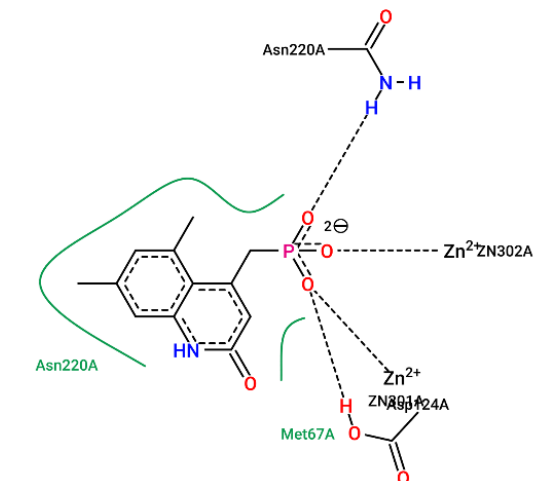
Figure 10: Ligplot illustration of methyl group in ligand/NDM-1 interaction. This is heteroaryl phos- phonate derivative with NDM-1, from PDB 6D1J. The two methyl groups form hydrophobicity with Asn220A, marked by the green spline